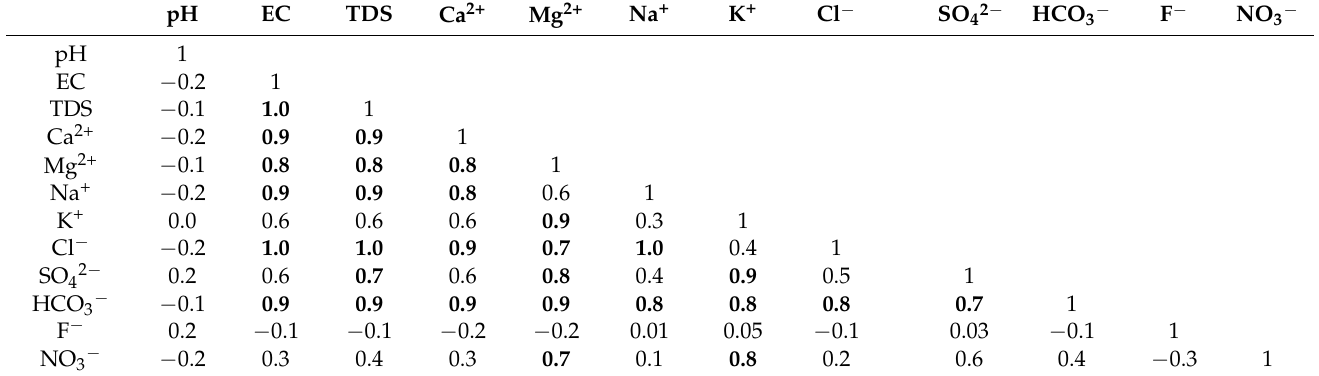
Table 2. Correlation coefficients of major physiochemical parameters determined in the water samples collected from boreholes and springs located in the Soutpansberg